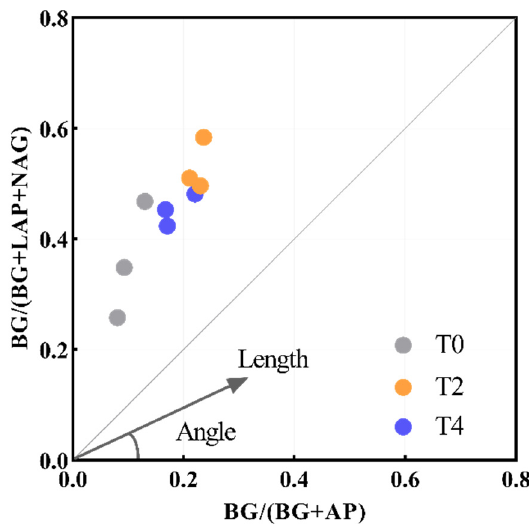
Figure 6. The variation of vector length and angle. T0: control without warming; T2: 2 °C warming treatment; T4: 4 °C warming treatment.